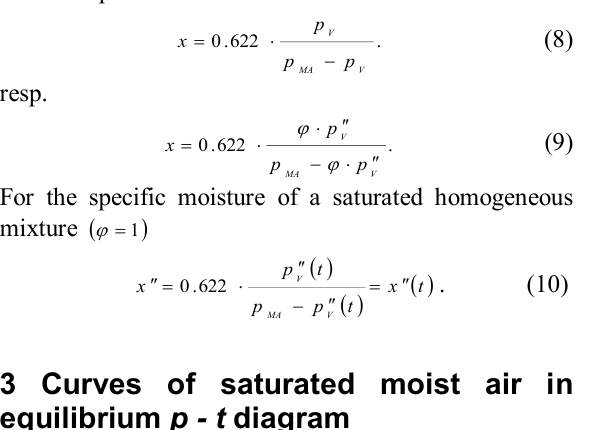
Saturation lines for x = const.